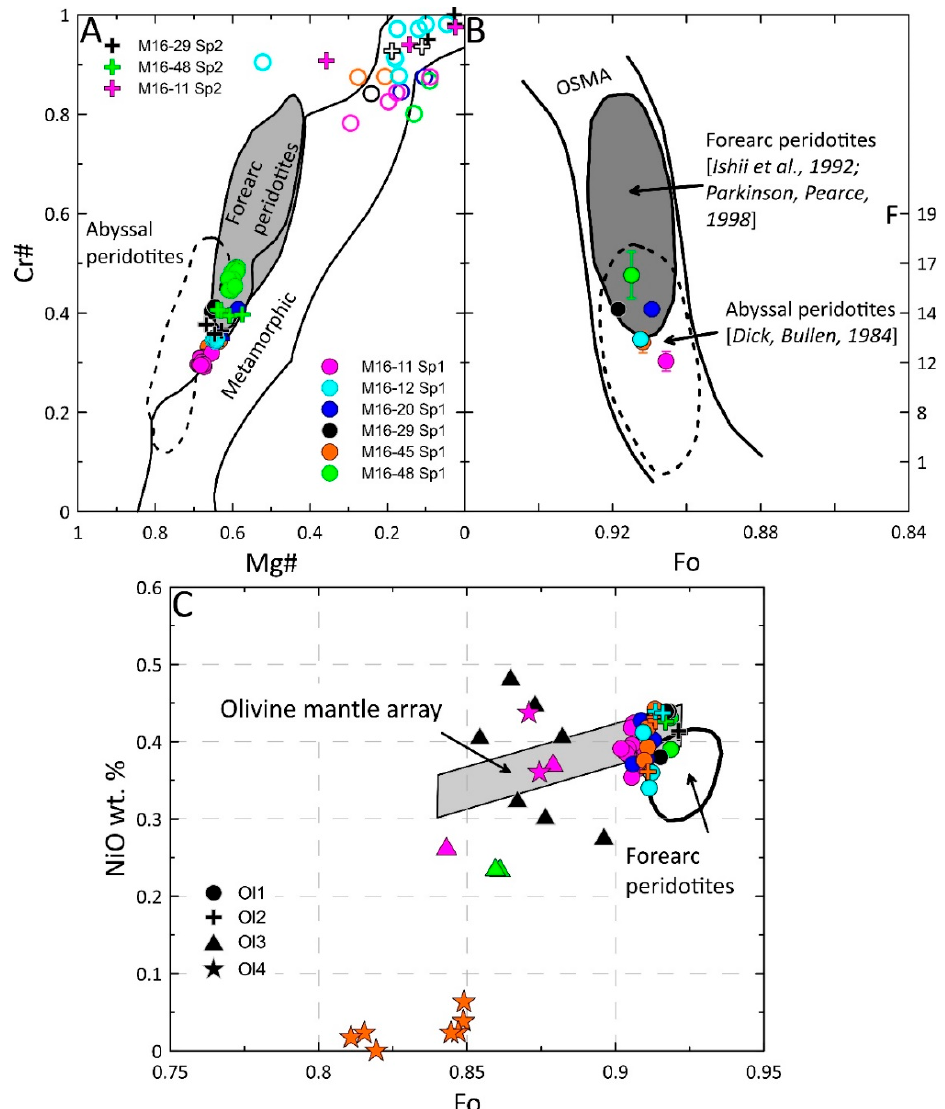
Figure 3. Compositional variations of spinel and olivine from the Alag Khadny peridotites. ( A ) Cr/(Cr + Al) vs. Mg/(Mg + Fe 2+ ) of spinel, Sp1—spinel porphyroclasts, Sp2—newly formed spinel, filled symbols are cores, and empty symbols are rims; the abyssal peridotites field is from [40], forearc peridotites are from [41], and the metamorphic spinel field is from [42]. ( B ) Cr/(Cr + Al) of spinel (Sp1) vs. Fo of olivine (Ol1). Olivine-spinel mantle array (OSMA) is after [43], F—Cr# based melting degree after [44]. ( C ) NiO content vs. Fo of olivine, Ol1—primary olivine, Ol2—newly formed olivine, Ol3—metamorphic olivine associated with tremolite, and Ol4—iron-rich olivine bands after Ol1 and Ol2. Different colors of the symbols are referred to different samples as shown in ( A ). The olivine mantle array is from [45], and the field of forearc peridotites is from [41].